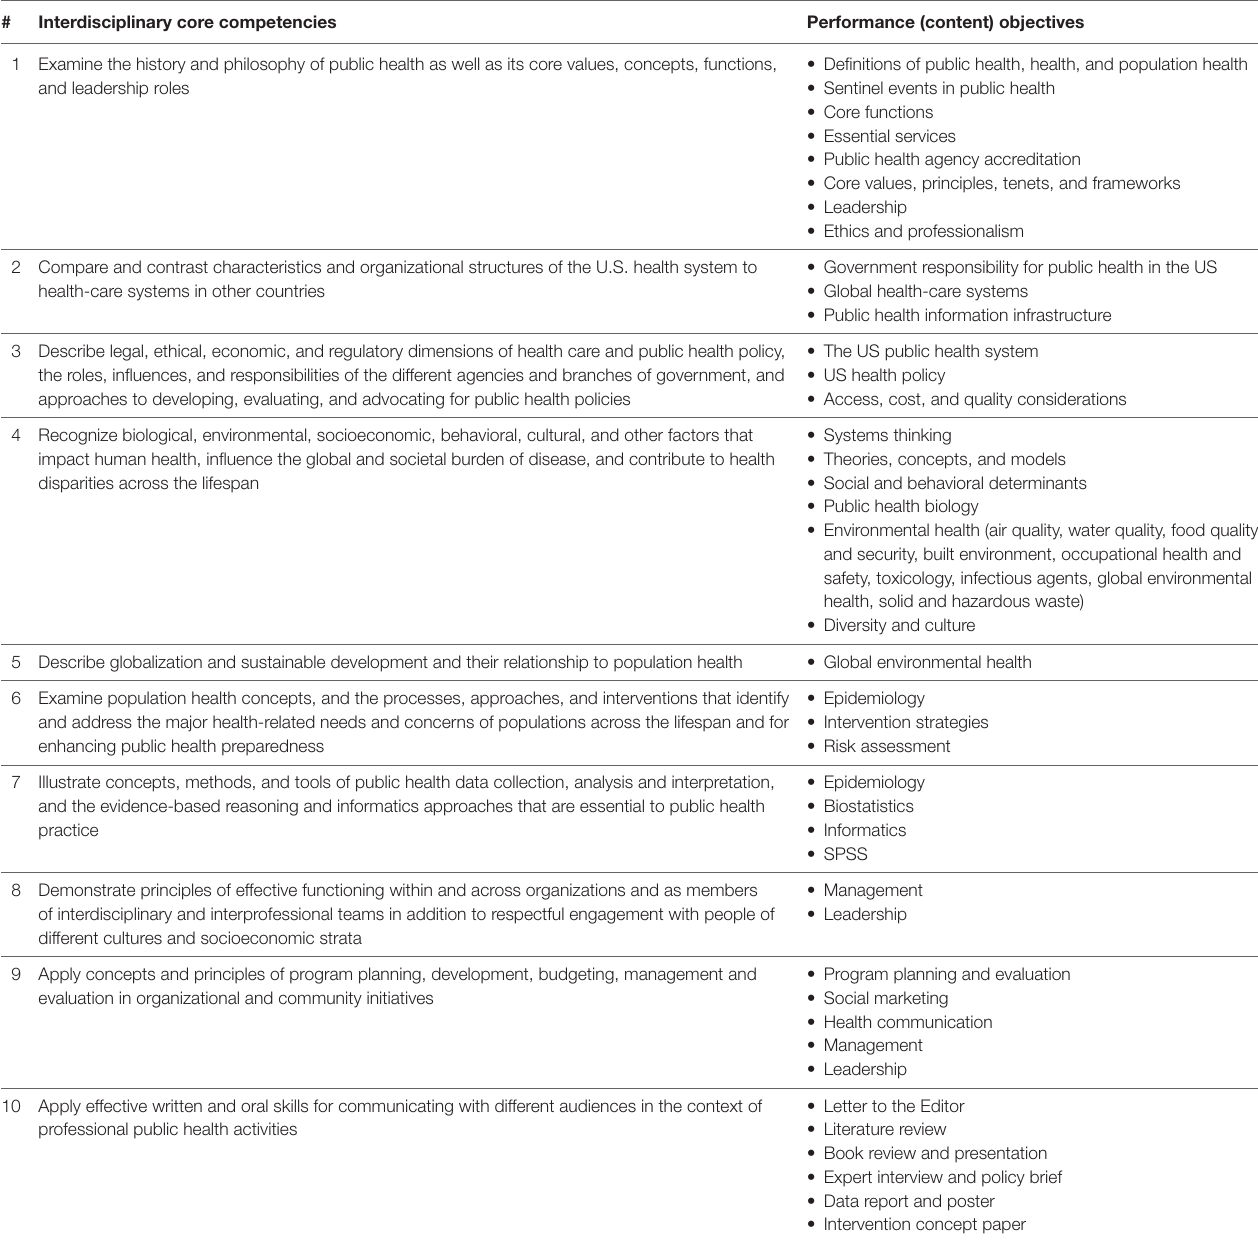
taBle 2 | Matrix of interdisciplinary core competencies and performance